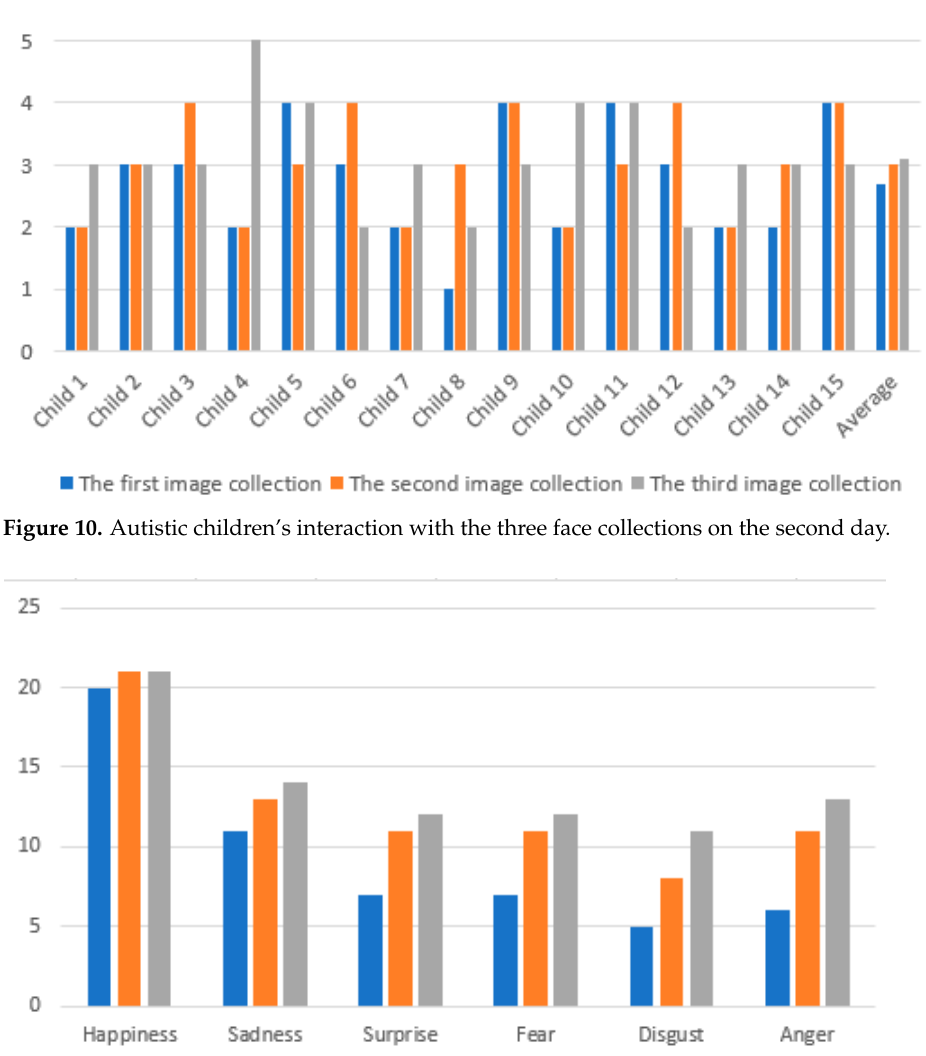
Figure 10. Autistic children’s interaction with the three face collections on the second day. Table 8. The caregiver reports on child interaction with the facial expression of the three face collections with correct answers (0–20) for ASD children in the two days.